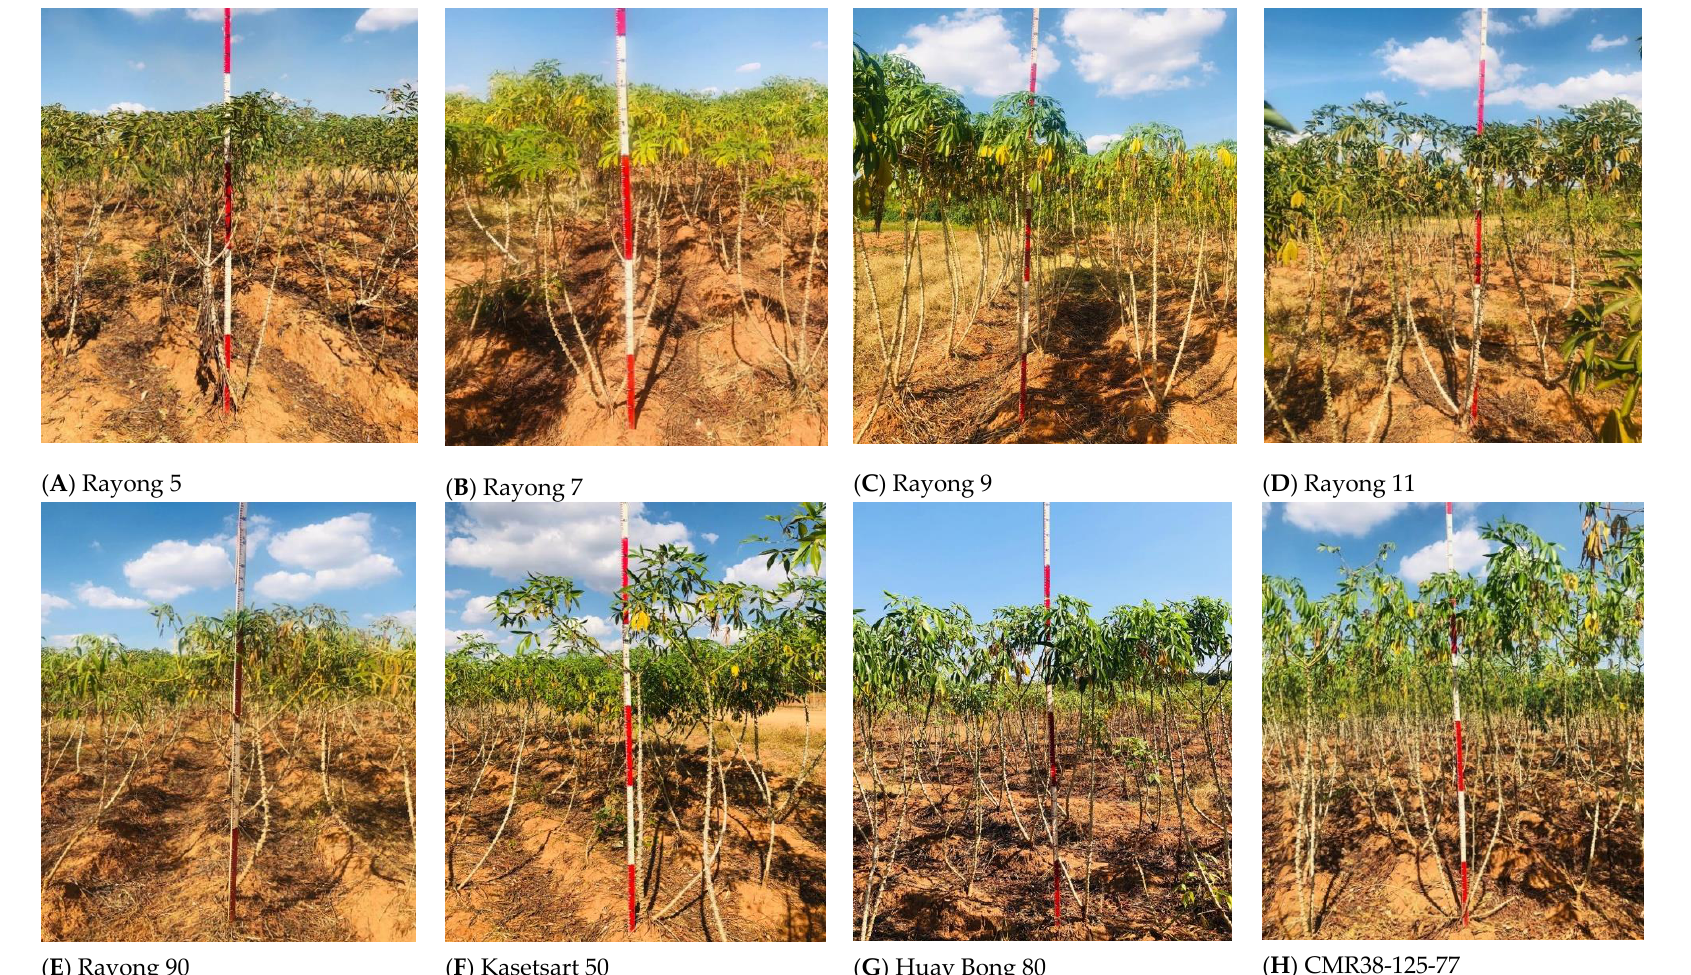
Figure 1. The eight different cassava genotypes ( A – H ) at 10 months after planting (dry period) for an experiment during 2019/2020 in Khon Kaen University, Thailand. There was limited rainfall from 8 up to 12 months after planting.